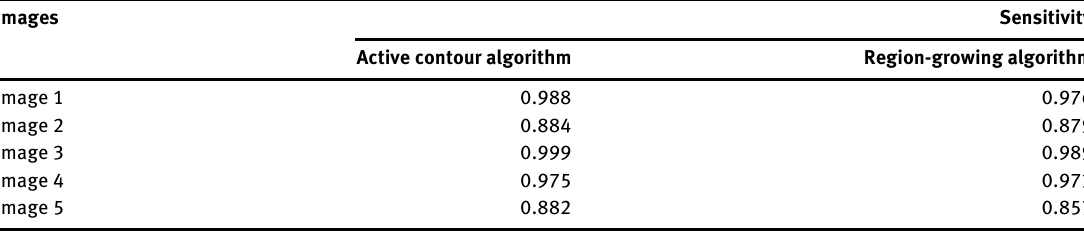
Table 4: Sensitivity Comparison of the Proposed Segmentation.